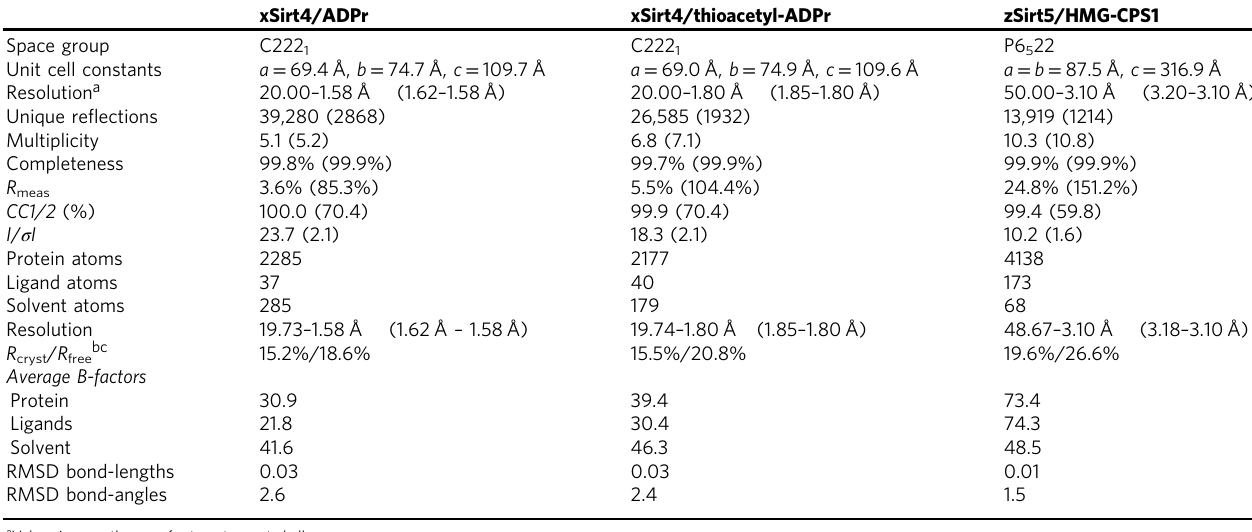
Table 2 Data collection and re fi nement